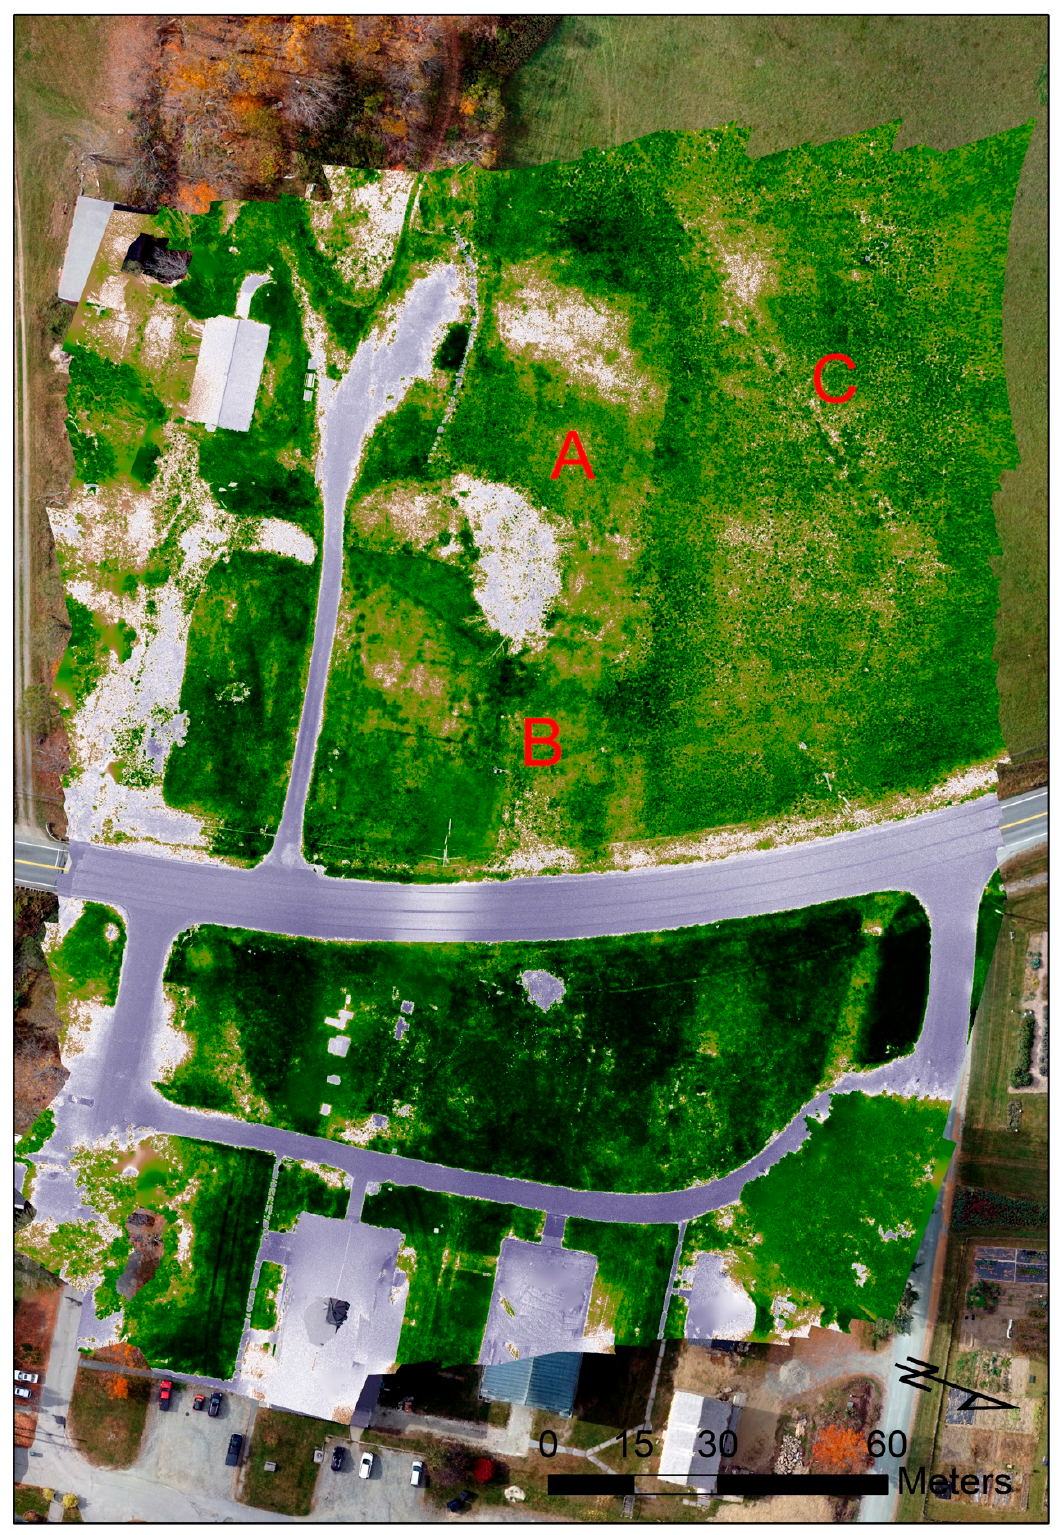
Figure 5. NDVI map of Enfield Shaker Village (recorded 11 May 2017 at 50 m altitude). A: building foundation; B: building foundation; C: modern pipe.